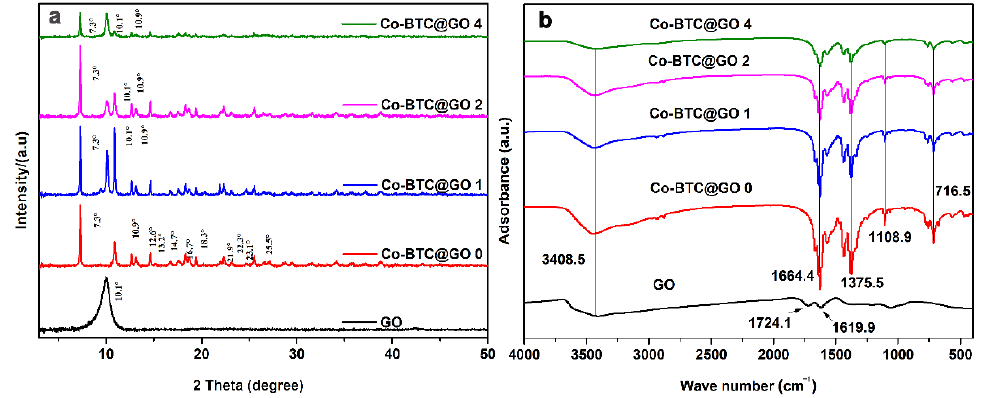
Figure 2. ( a ) XRD patterns for the GO, Co-BTC, and Co-BTC@GO composites; ( b ) FT-IR spectra of the GO, Co-BTC, and Co-BTC@GO composites. the GO, Co-BTC, and Co-BTC@GO